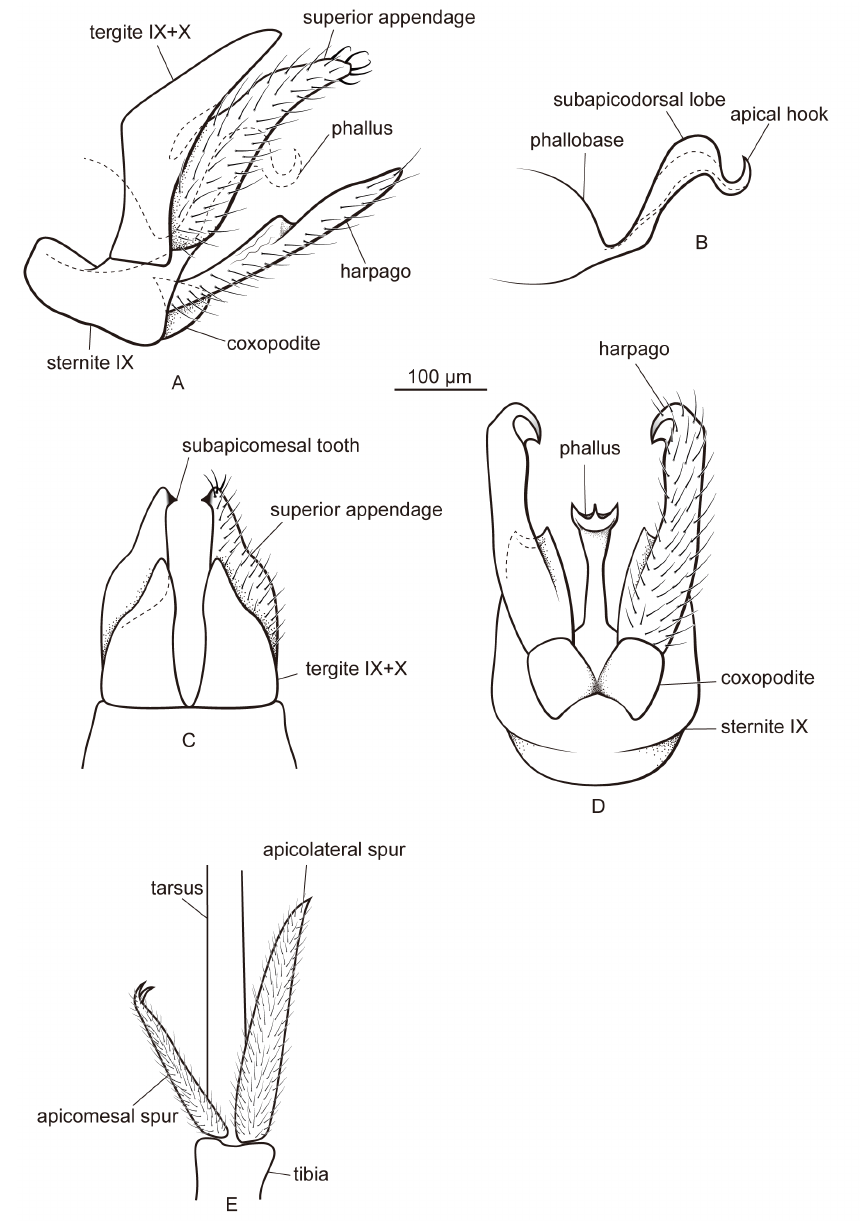
Figure 2. Male of Metalype hubeiensis sp. n. A genitalia, left lateral B phallus, left lateral C genitalia, dorsal D genitalia, ventral E apical spurs of right hind leg,